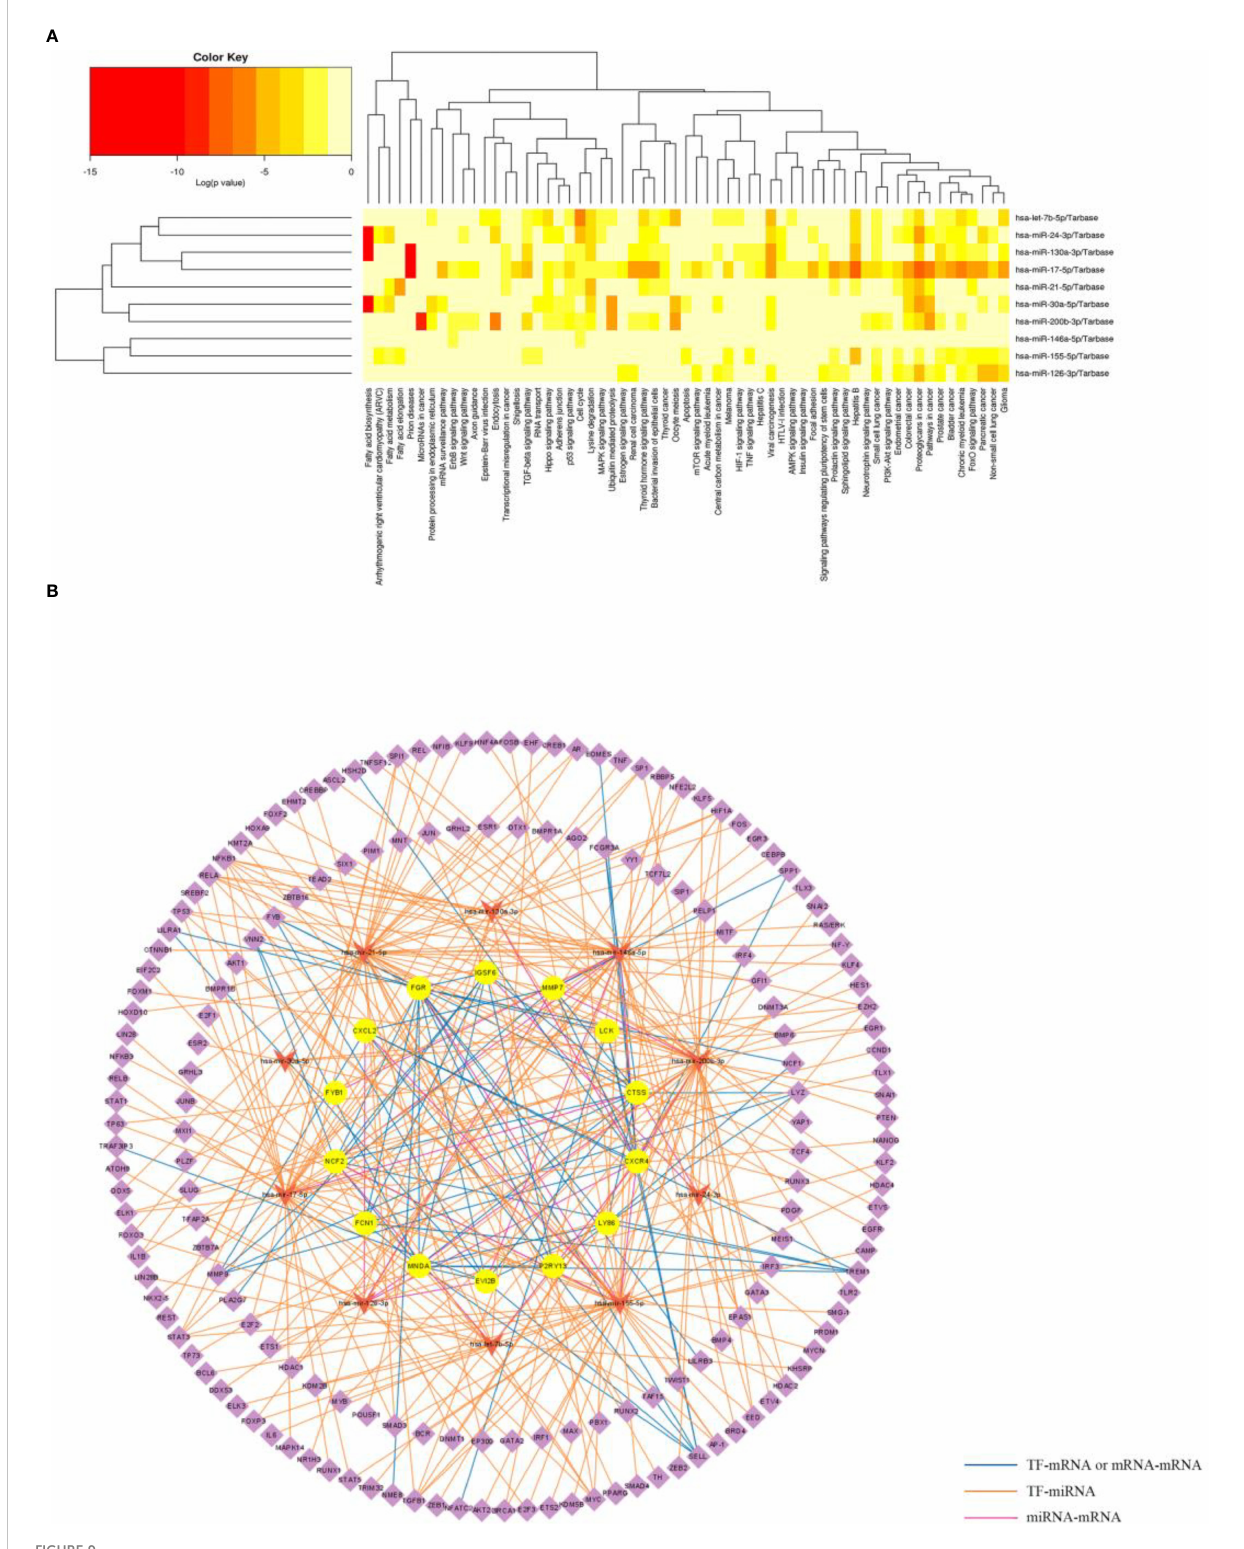
FIGURE 9 Functional enrichment analysis of the miRNAs and construction of TF-miRNA-mRNA network. (A) Signi fi cantly enriched biological pathways of the common miRNAs in OB and PD using the mirPath database. (B) The common TF-miRNA-mRNA regulatory network in OB and PD, where circles represent hub genes, inverted triangles represent miRNAs and diamonds represent transcription